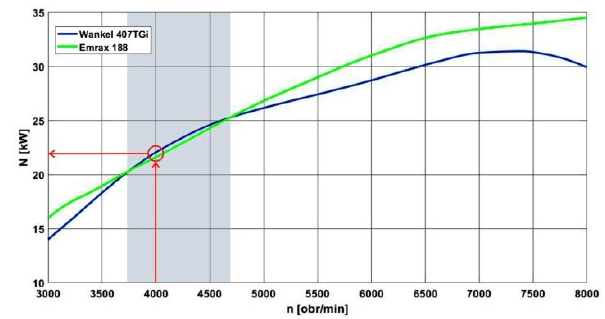
Fig. 7. Rotational characteristics of the 407tgi